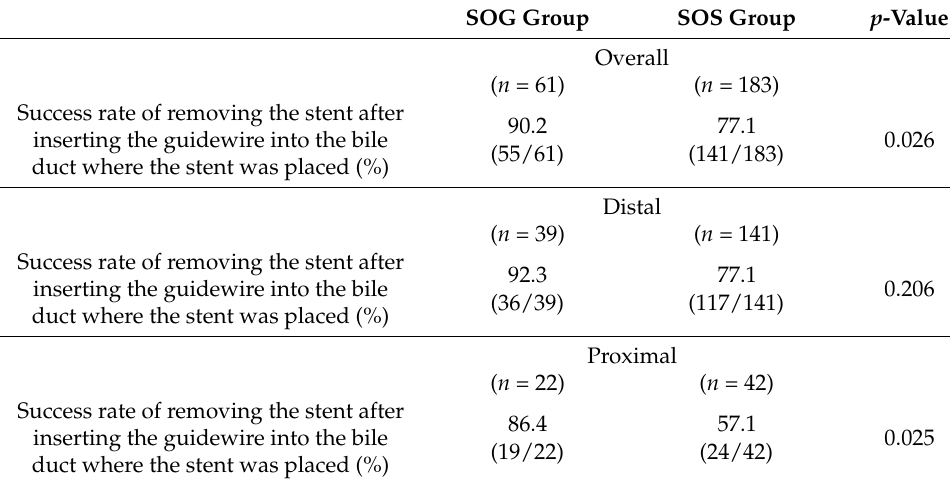
Table 2. Comparison of procedural success rates between the SOG and SOS groups. Success rate of removing the stent after inserting the guidewire into the bile duct where the stent was placed (%)